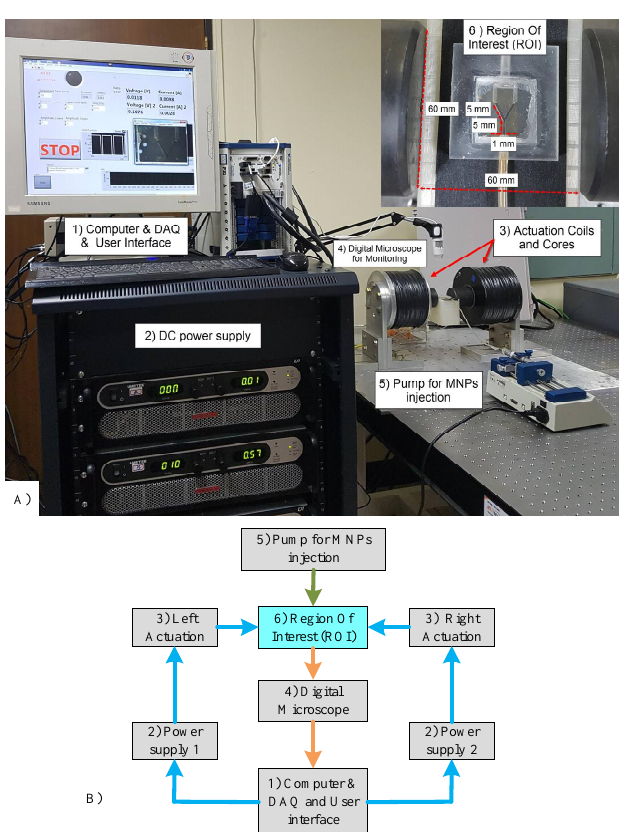
Figure 7. ( A ) The electromagnetic actuator comprises two coils (5000 turns and diameter of wire of d w = 1.0 mm) with two cores to increase the magnetic field density (cobalt–iron alloy VACOFLUX 50, VACUUMSCHMELZE, German); the cores are 19.5 cm in length and 6 cm in diameter. Two power supplies (AMETEK SGA 600/17, 10 kW) were utilized to generate currents of up to 6 A (gradient field strength of 2.8 T/m) in the experiments. ( B ) Schematic of the